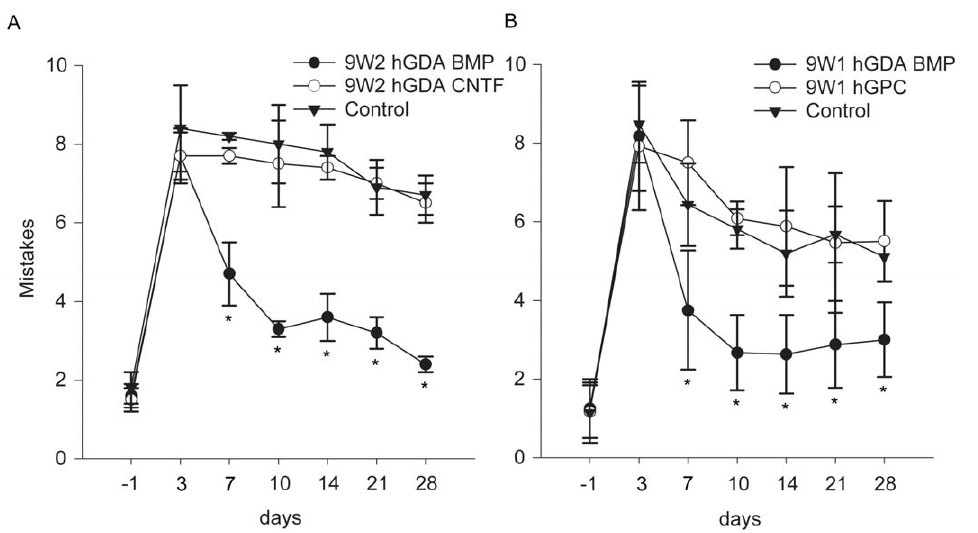
Figure 5. Human GDAs BMP promote robust locomotor recovery but hGDAs CNTF and hGPCs do not. Graphs show the average number of mistakes per experimental group made during Grid walk testing of locomotor recovery at 1 day before injury to 28 days after injury. In two separate experiments, hGDA BMP transplanted animals (closed circles) performed significantly better than hGDA CNTF (A) or hGPC (B) transplanted animals at all time points from 7 to 28 days post injury/transplantation. Note that the performance of hGDA CNTF or hGPC transplanted animals was not significantly different from control injured rats at all time points (two-way repeated measures ANOVA, *p , 0.05).